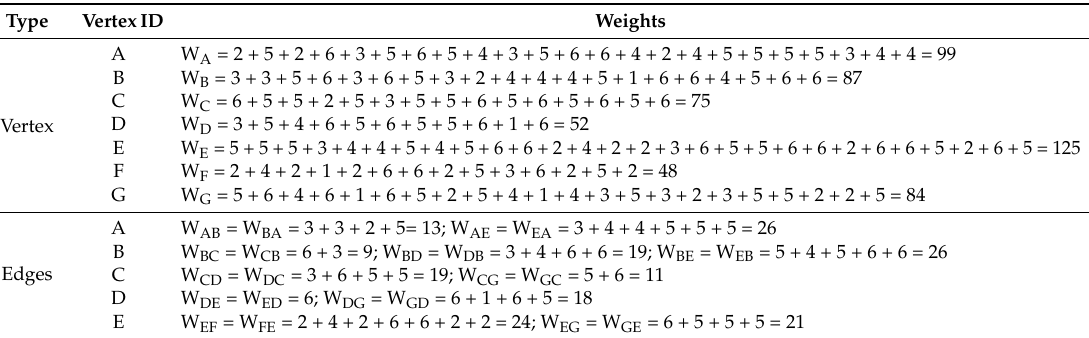
Table 2. Graph weight evaluation.